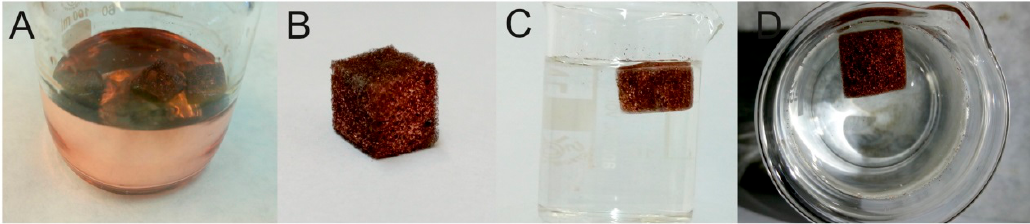
Figure 6. Copper mirror formed on the surface of the reaction glass beaker during the decoration of